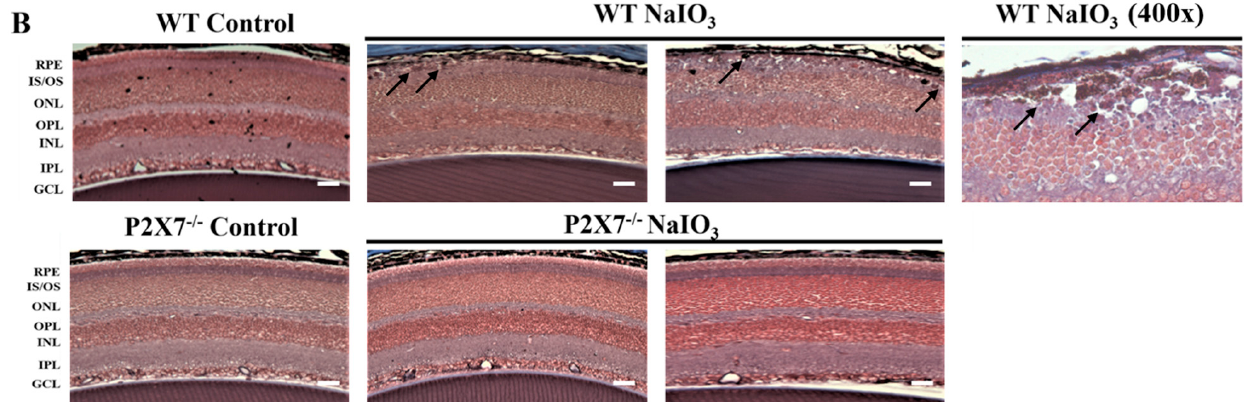
Figure 4. Histological examination of PAS and Masson trichrome staining. Representative light microscope images of PAS ( A ) and Masson trichrome ( B ) staining of retinal sections in WT and P2X7 − / − mice at 3 days post-intraperitoneal injection of NaIO 3 (25 mg/kg) were shown. The visible retinal pigment granules were shown as black arrows in both PAS ( A ) and Masson trichrome ( B ) staining. The mice number for PAS staining was 5 for each group and for Masson trichrome staining was 7 for each group. Scale bar: 200 µ m.